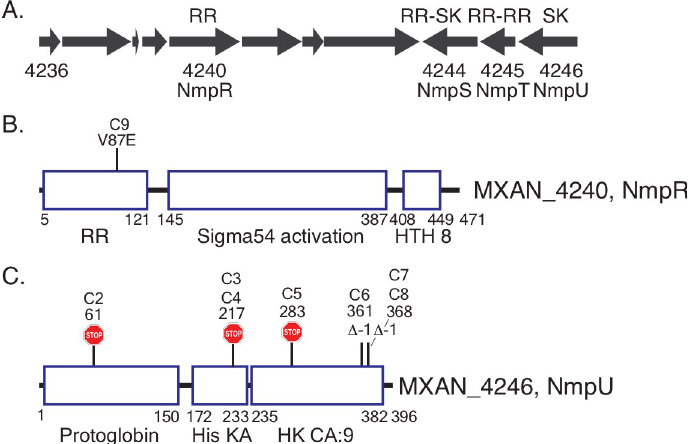
Fig 2. Suppressor mutations identified in uncharacterized TCS signaling genes. Suppressor strains were sequenced with the Illumina MiSeq platform and compared to the annotated M . xanthus DK1622 genome [27]. (A) Genomic organization of the locus containing the RR gene mxan_4240 ( nmpR ) (B) and SK gene mxan_4246 ( nmpU ) (C). This locus also contains a gene encoding a protein with two RR receiver domains ( mxan_4245 , nmpT , RR-RR) and an atypical hybrid response regulator/sensor kinase ( mxan_4244 , nmpS , RR-SK). The results of the mutations are depicted (B and C): a missense mutation in nmpR (V87E) and premature stop codons (stop signs) or frameshifts ( Δ -1) in nmpU . The location of the mutations within each protein is to scale. The positions of each domain of these proteins is also indicated by amino acid number (RR = response regulator receiver domain, Sigma54 activation = central ATPase that interacts with σ 54 , HTH_8 = DNA-binding helix-turn-helix, Protoglobin = putative heme binding sensor domain, HisKA = domain of histidine phosphorylation and SK dimerization, HK CA:9 = ATPase. All domain nomenclatures are based on the Mist 2.2 database [87] and Pfam (http://pfam.xfam.org, [93]). The strain designation (C1-C9) is the same as in Table 1 and Fig